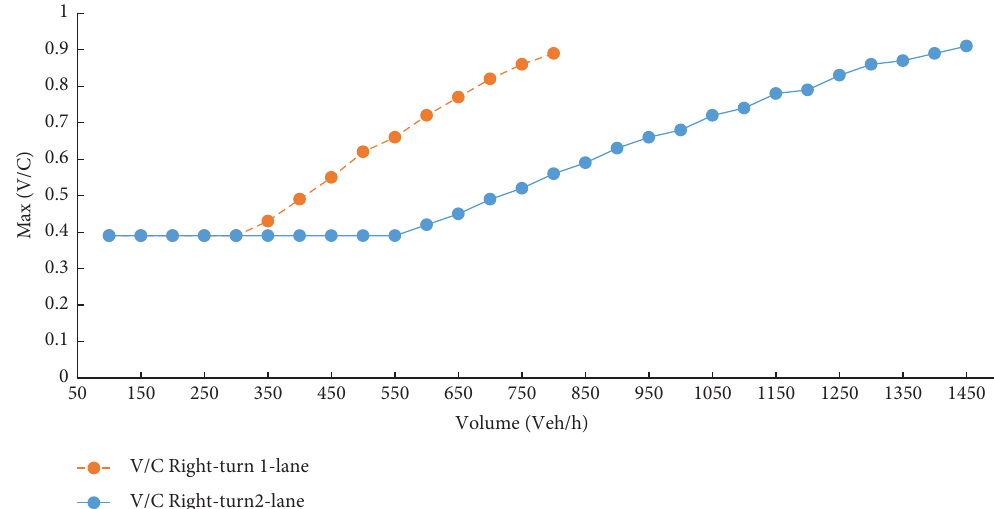
Figure 10: Comparison of changing a single and dual right-turn lane in volume to capacity (v/c)